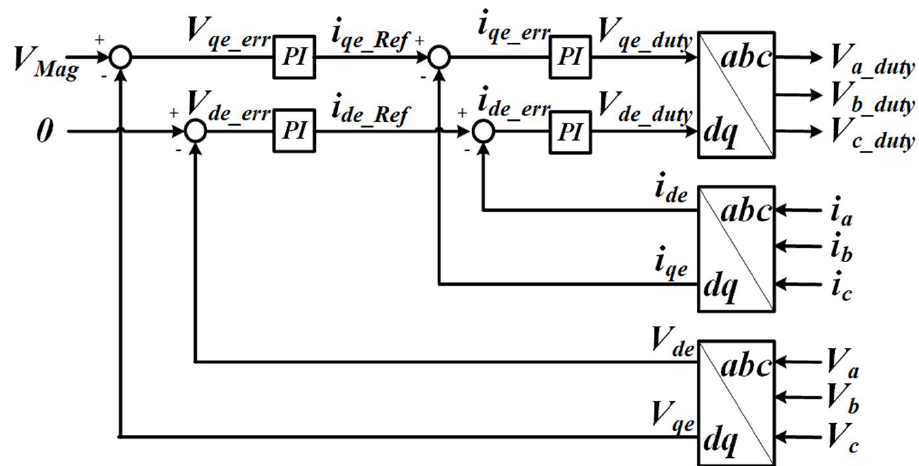
Figure 10. Part of the inverter.